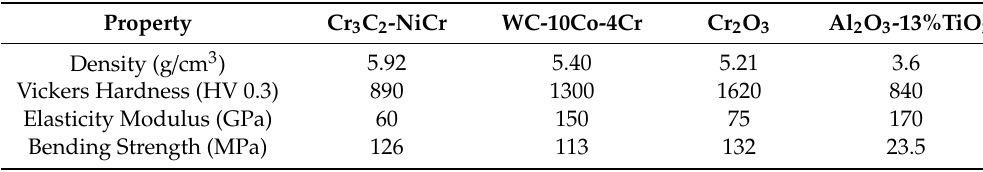
Table 3. Main physical performance of Cr 3 C 2 -NiCr, WC-10Co-4Cr, Cr 2 O 3 and Al 2 O 3 -13%TiO 2